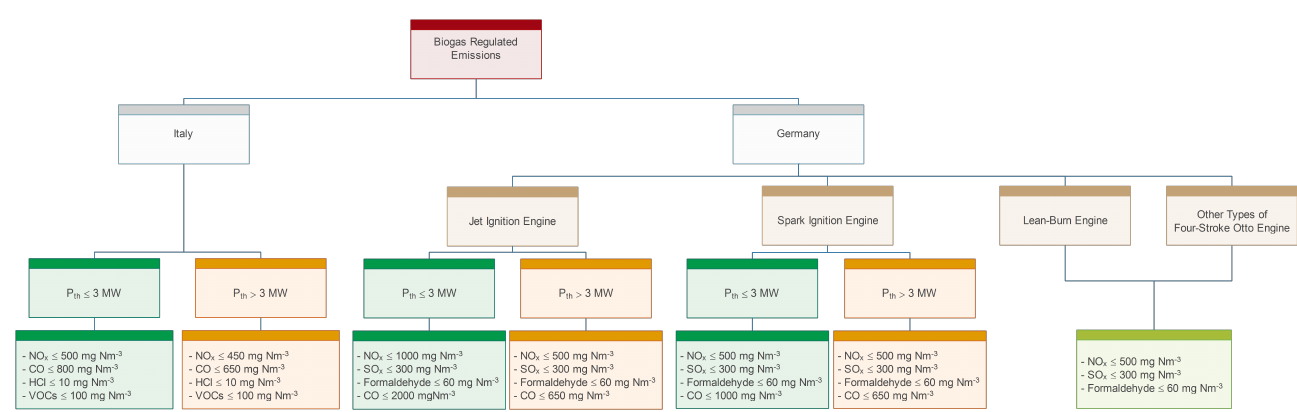
Figure 1. Italian and German regulatory limits for biogas plants as defined by the countries’ standards